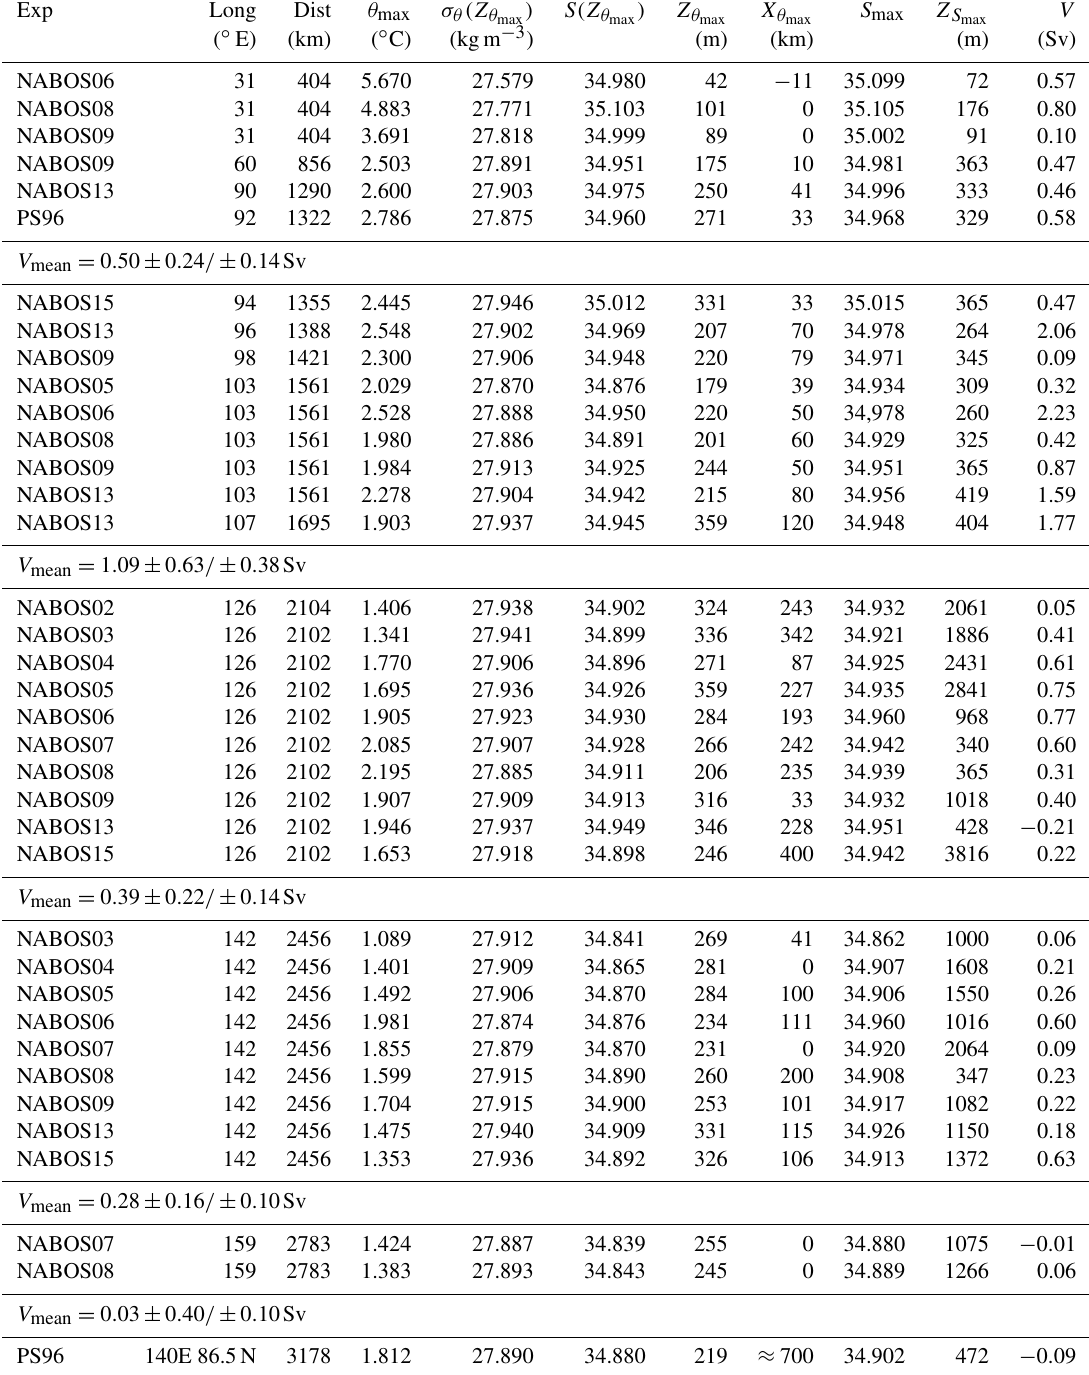
Table 1. Characteristics of the Atlantic water flow in the course of its propagation along a continental slope of the Eurasian Basin of the Arctic Ocean. “Dist” is the along-slope distance from Fram Strait; θ max is the maximum temperature; σ θ (Z θ X θ are the values of potential density, salinity, depth, and lateral displacement from the slope for the point θ max ; S max and Z S max maximum salinity and depth of S max ; V is the geostrophic estimate of the volume flow rate. The mean values, 95% confidence intervals, and 80% confidence intervals of the volume flow rate, V mean , calculated separately for CTD transects at 31–92, 94–107, 126, 142, and 159 ◦ E, are also shown. The last row in the Table presents the characteristics of the return flow of the AW by the Lomonosov Ridge at 140 ◦ E and 86.5 ◦ N (PS96; see Fig.